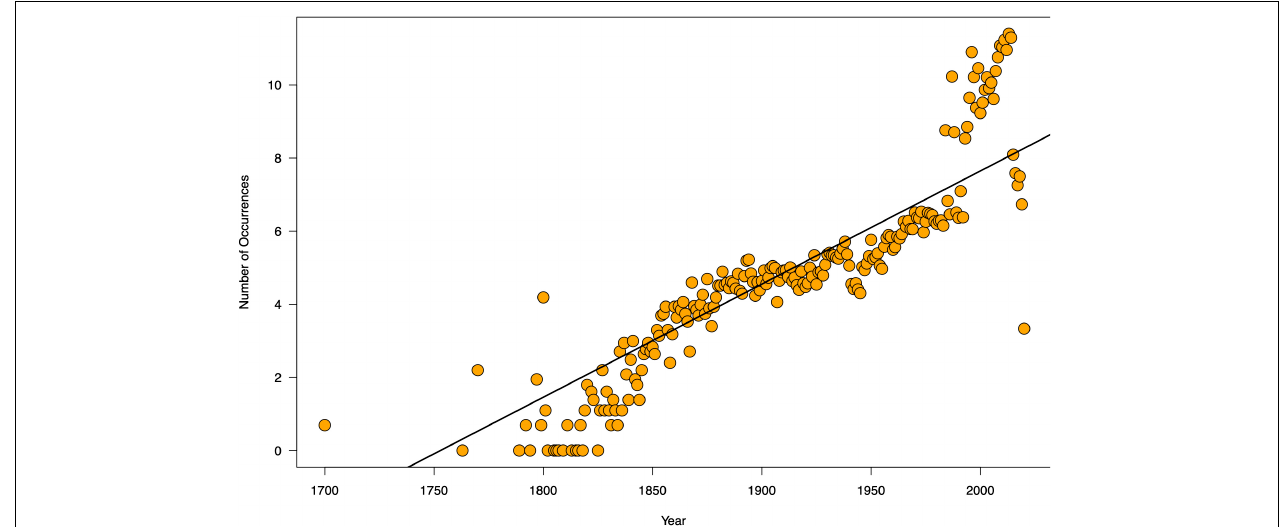
FIGURE 9 | Temporal change in the amount of seagrass occurrence records over time. Seagrass point records downloaded from GBIF were mapped over time based on the chronological date listed in the occurrence data for each record to demonstrate that seagrass occurrences have greatly increased within recent decades. This indicates that analyses with these data will be computationally expensive. Source data are provided as a Source Data